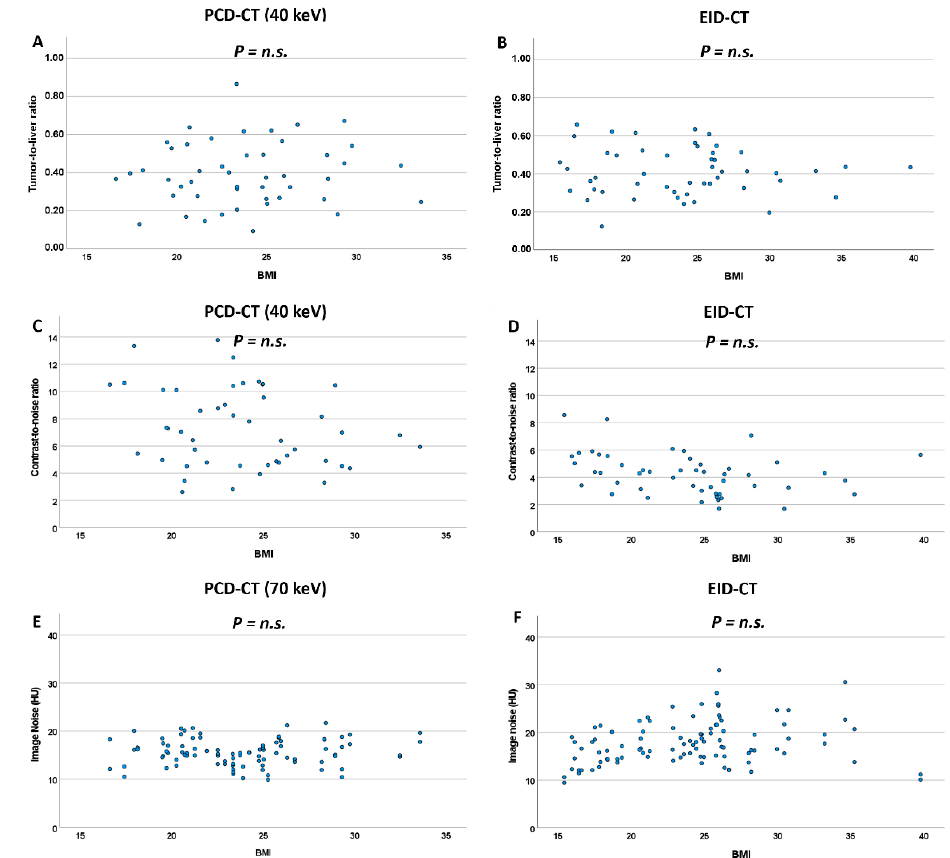
Figure 5. Scatterplots for TLR ( A , B ), CNR ( C , D ) and image noise ( E , F ) against BMI for the PCD-CT and EID-CT system. n.s.: non significant.